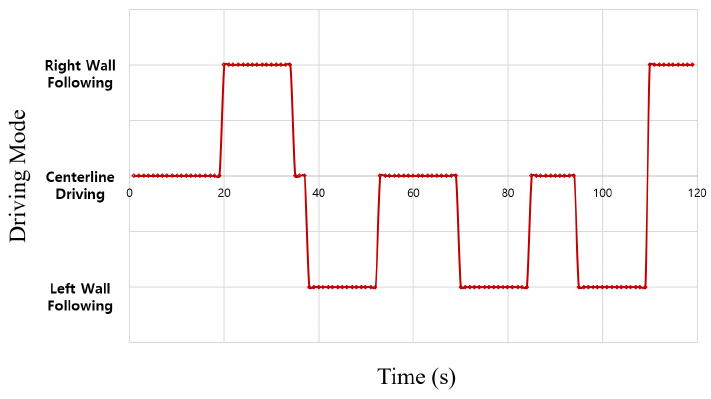
Figure 7. Graph showing the change in autonomous driving and wall-following mode in the field Figure 7. experiment.